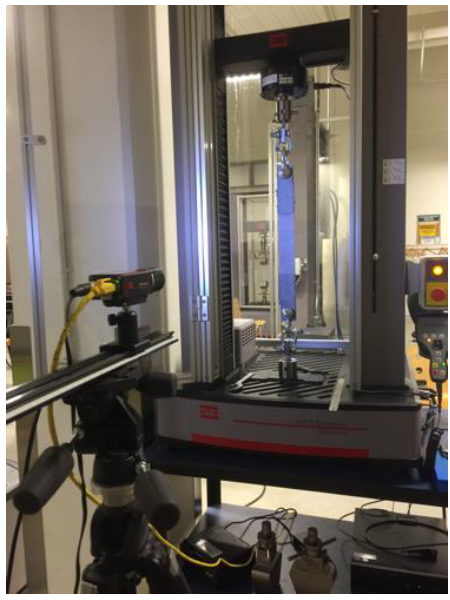
Figure 2. Clevis grips.